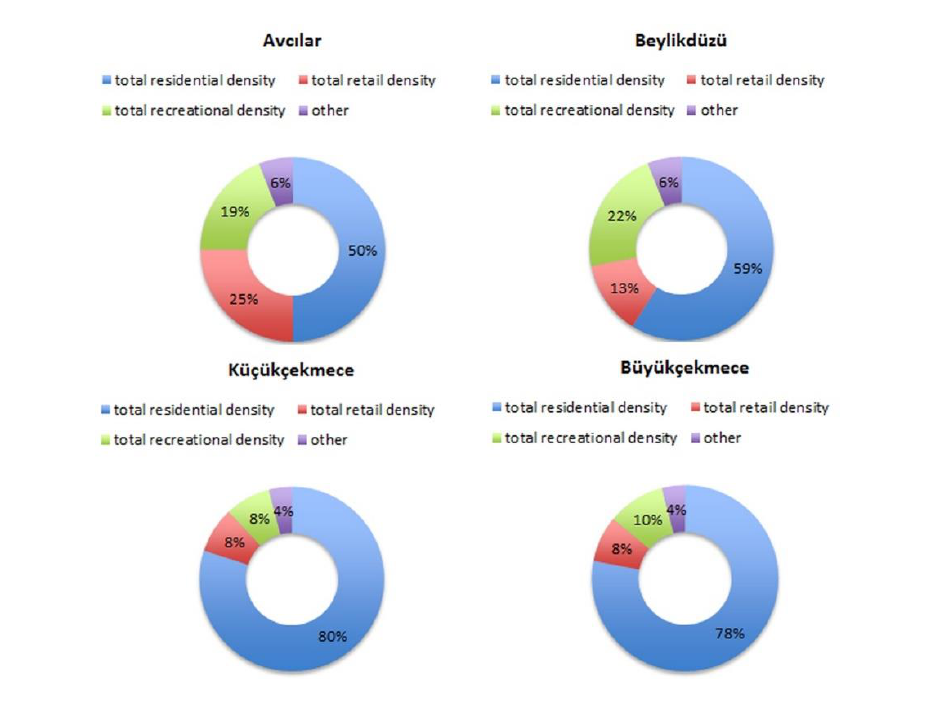
Figure 8 Land-use distributions within 800meter circular buffers of selected